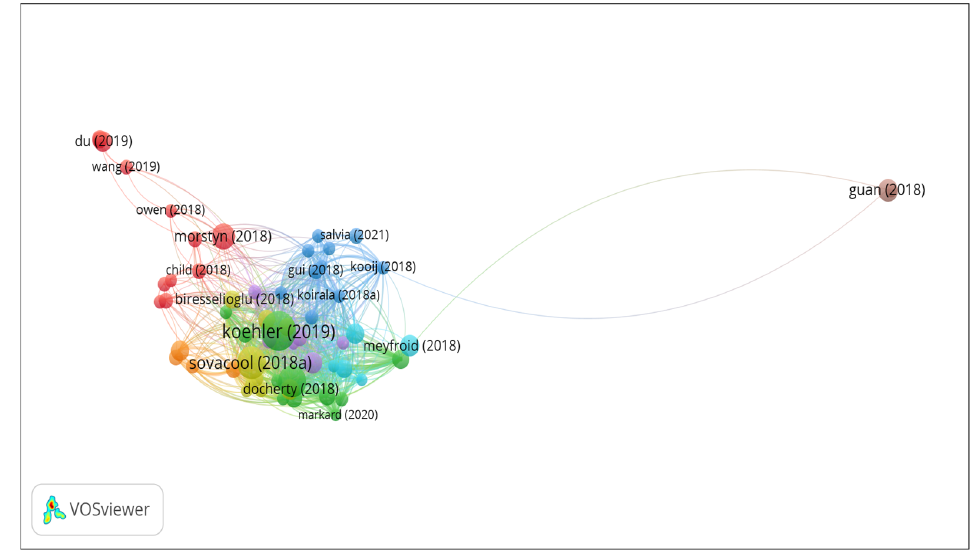
Figure 7. VOSviewer diagram containing the most cited papers (with at least 70 citations), for the couple: social innovation–energy transition .